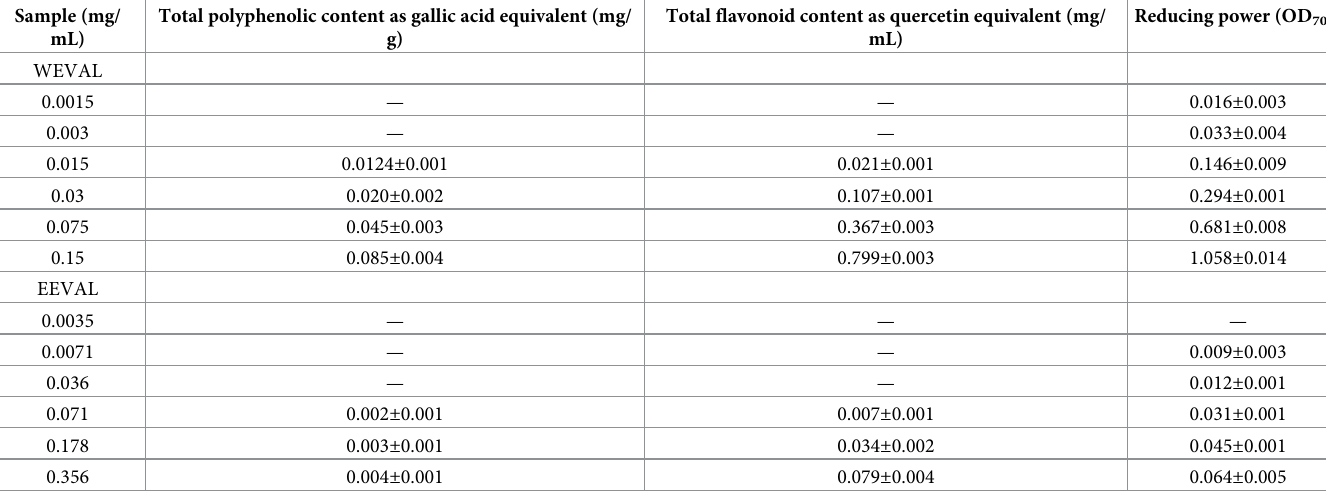
Table 2. Total phenolic, total flavonoid contents and reducing power of WEVAL and EEVAL. Sample (mg/ Total polyphenolic content as gallic acid equivalent (mg/ mL)